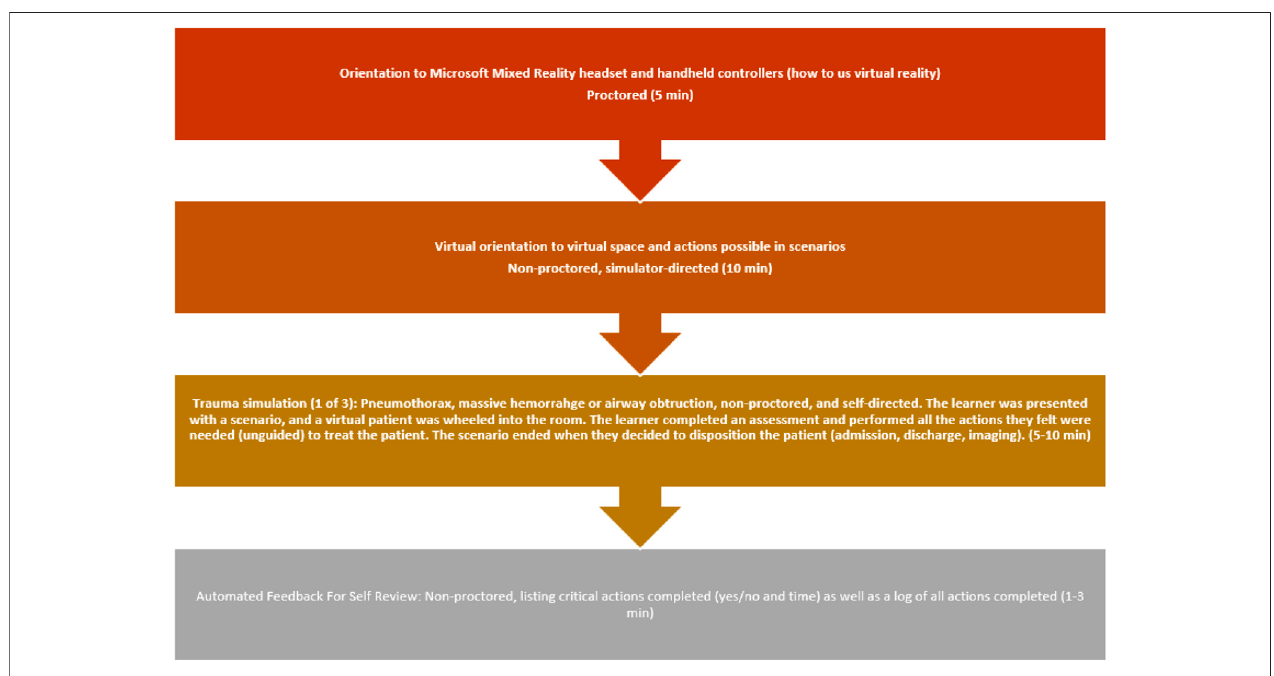
FIGURE 7 | Flowchart of participant experience.